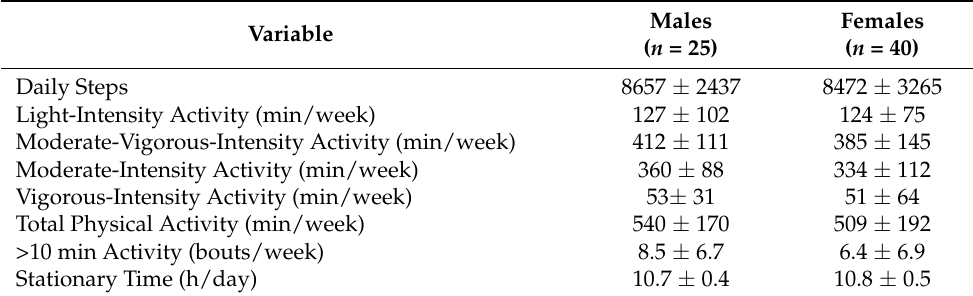
Table 2. Objectively measured physical activity in current kinesiology students.